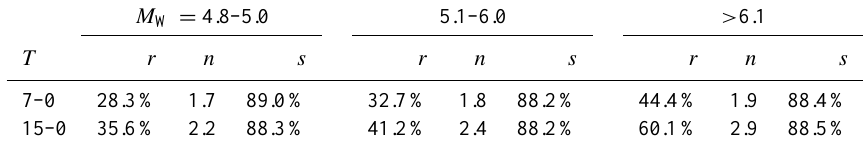
Table 5. The statistical results concerning seismic ionospheric influences on the ion density ( D = 0–1000km, d = 0–1000km). M W = 4.8–5.0